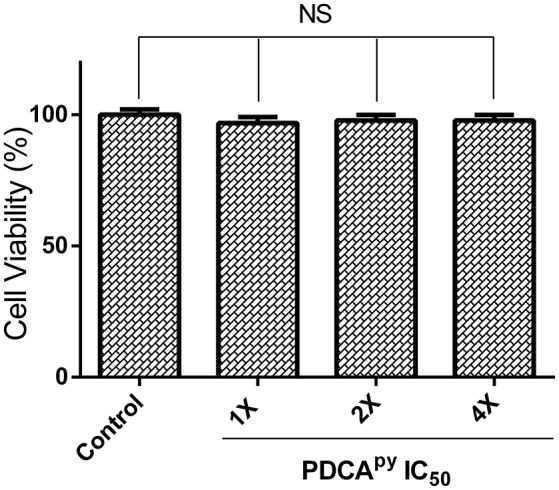
Cell viability of HepG2 cells treated with PDCApy. Cell viability of HepG2 cells was not affected as indicated by the insignificant difference between control and treated at its IC50 concentration, 1X = 25 μM, 2X = 50 μM, 4X = 100 μM. NS denotes no significant differences (p > 0.05).